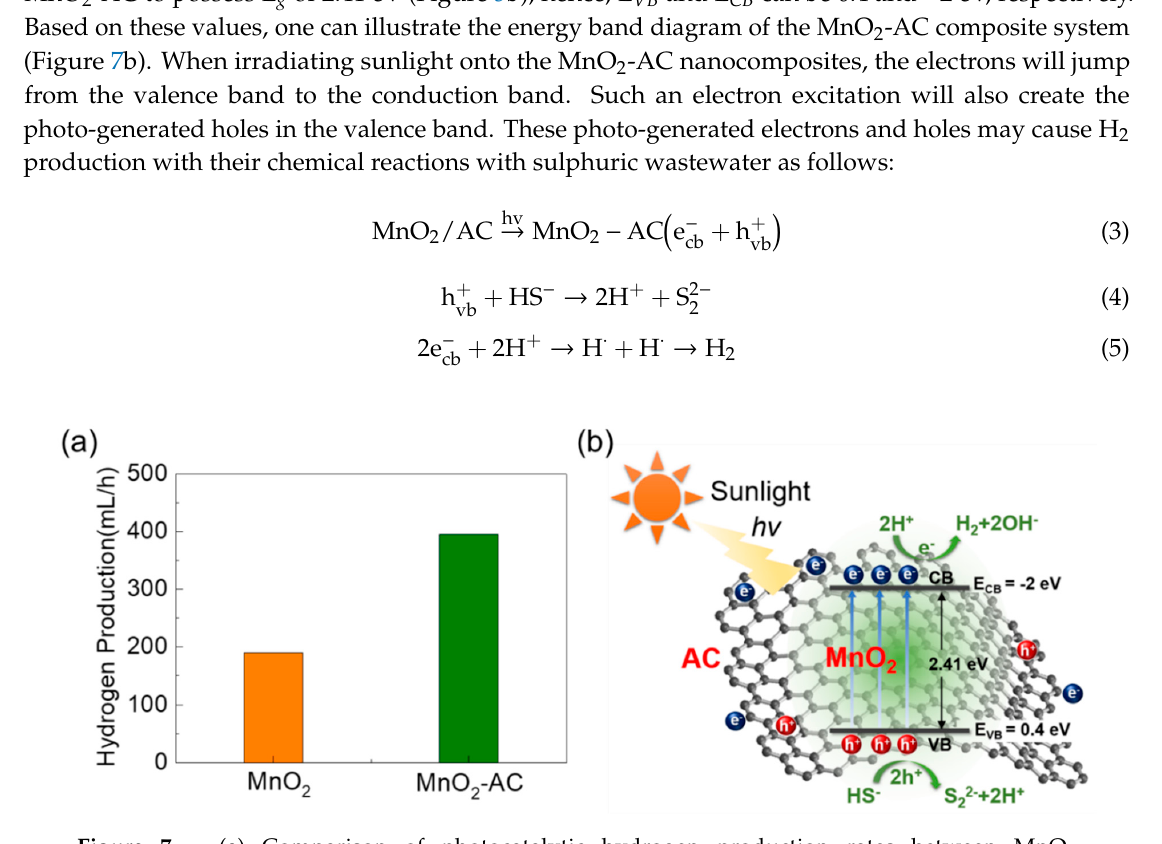
Figure 7. ( a ) Comparison of photocatalytic hydrogen production rates between MnO 2 nanoparticles and MnO 2 ‐ AC nanocomposites. ( b ) Photocatalytic hydrogen production mechanism in MnO 2 ‐ AC